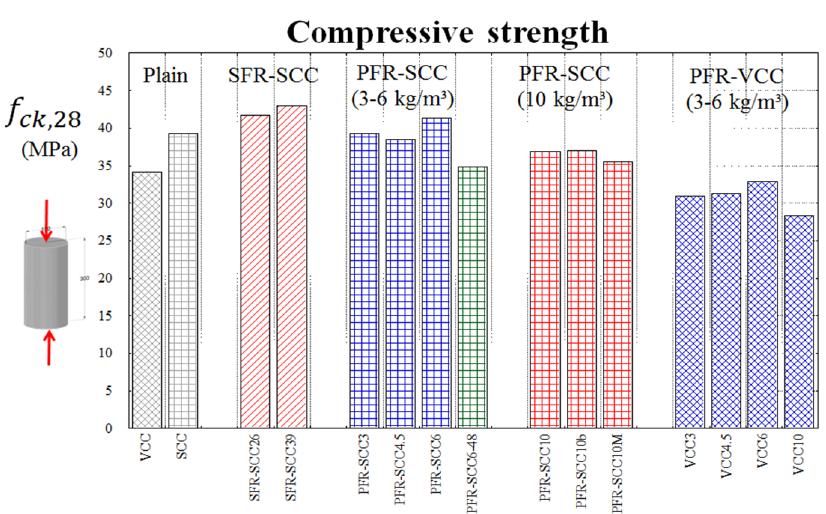
Figure 5. Compressive strength.